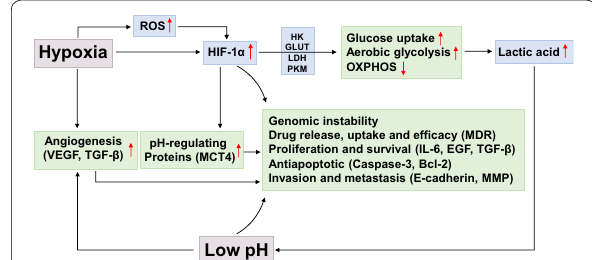
Fig. 4 The effect of hypoxia and acidic microenvironment on the occurrence and development of tumorigenesis. Red arrow denotes the increased metabolic activity. The hypoxic microenvironment in tumors would induce HIF-1α and ROS, which influence the expression of a series of metabolic enzymes, such as HK, GLUT, LDH and PKM, leading to metabolic transformation, increased glucose uptake, enhanced glycolysis, and decreased OXPHOS. The accumulated lactic acid can contribute to forming an acidic microenvironment. Hypoxia and acidic microenvironment will promote angiogenesis, tumor cell growth and apoptosis, drug resistance, and are also related to genomic